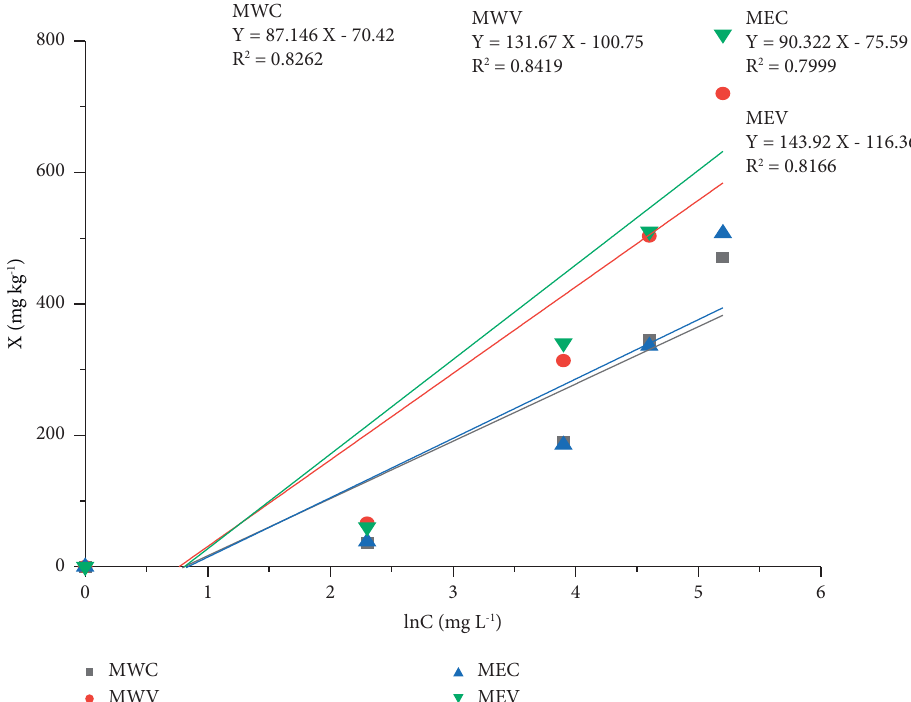
Figure 4: Linear Temkin isotherm for the soil of Meupi (24hours equilibration at 25 °